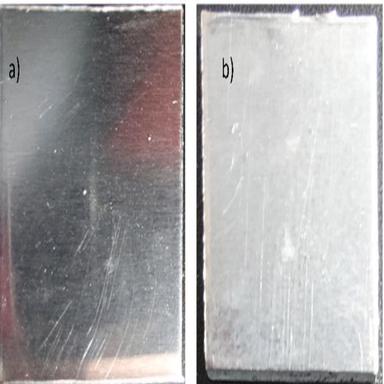
aluminium samples a) before corrosion. b) after corrosion.